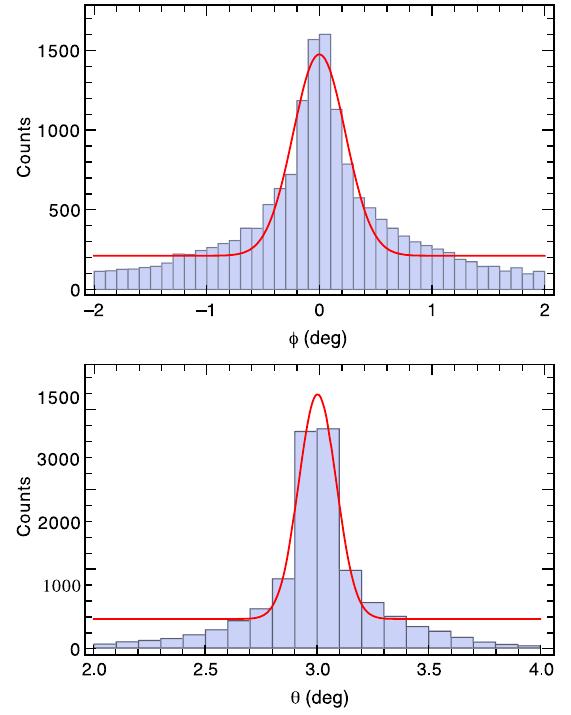
FIG. 33. Angular distributions for the simulation of groove scattering. The red curves are best-fit Gaussians with a flat background. Top: out-of-plane angle distribution; rms width of best-fit Gaussian: 0 . 23 °. Bottom: in-plane reflected angle dis- tribution; rms width of best-fit Gaussian: 0.08°.